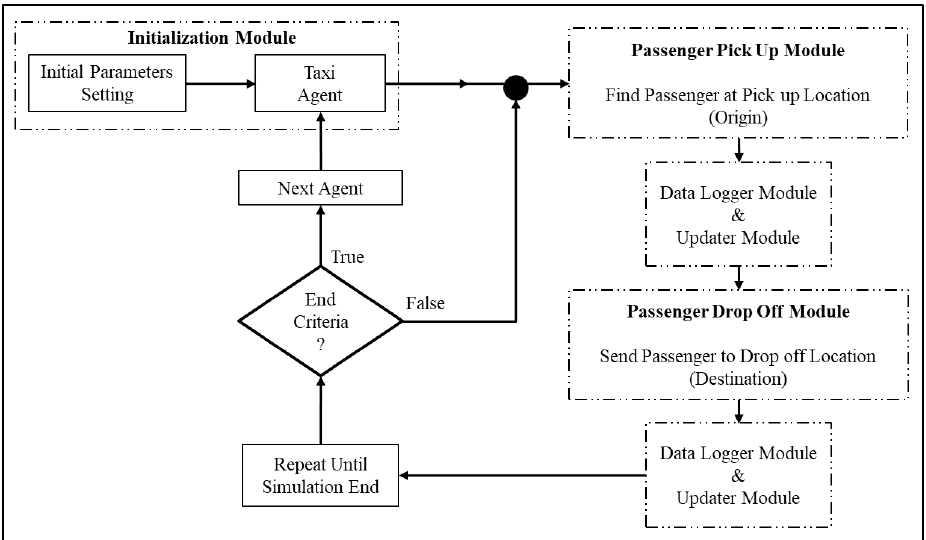
Figure 12. Agent-based simulation model.